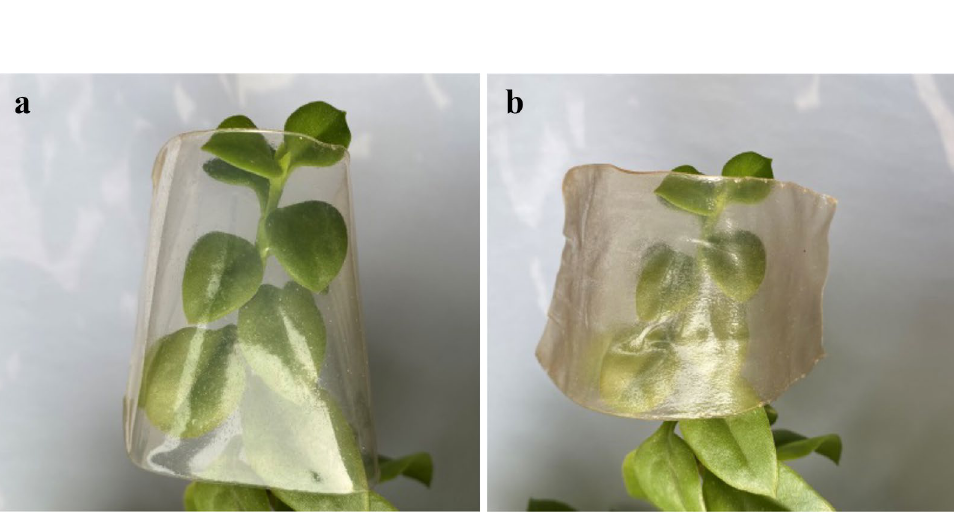
Figure 8. Digital photos of film with 5% ( a ) and 8% ( b ) MCC content in casting